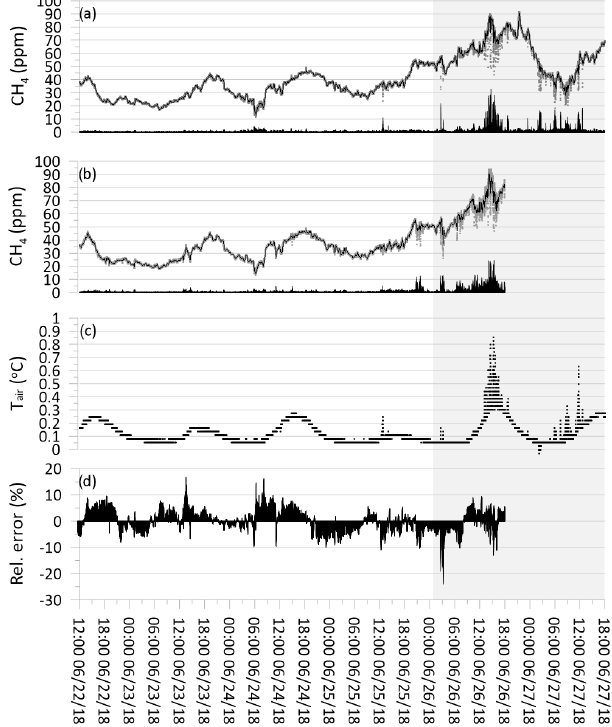
Figure 7. (a) Grey dots show raw CH 4 concentration from the cav- ity ring-down spectrometer (CRDS). Black line shows CRDS CH 4 concentration values following exponential smoothing. Black bars show absolute error between raw and smoothed values. (b) Grey dots show calculated raw CH 4 concentration from metal oxide sen- sor (MOS). Black line shows MOS CH 4 concentration values fol- lowing exponential smoothing. Black bars show absolute error be- tween raw and smoothed values. (c) Black dots show temperature of air in subglacial cavity. (d) Black bars show the relative error in percentage between MOS smooth and CRDS smooth divided by the CRDS smooth concentration. Grey background shading indicates pe- riod with higher observed turbulence at the margin of the GrIS. Temporal resolution is